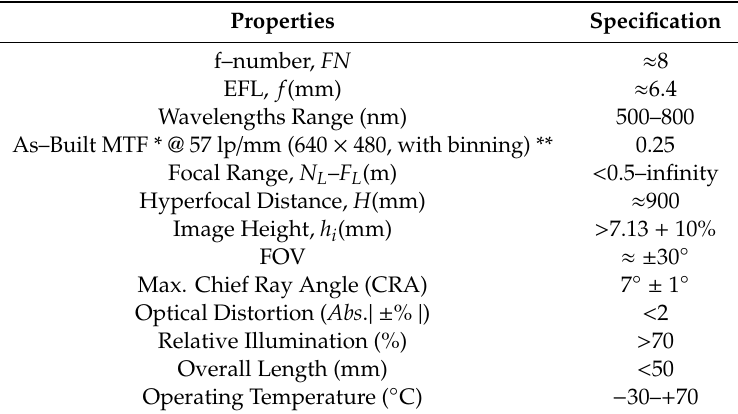
Table 2. Specifications of the space autonomous docking camera.